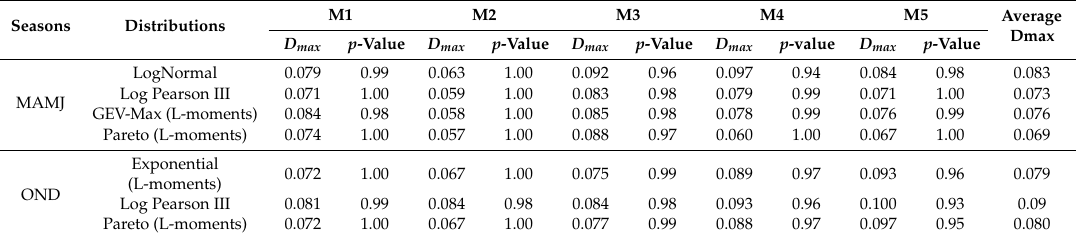
Table 8. Best-fitting distributions for the maximum one day rainfall in March–April–May–June (MAMJ) and October–November–December (OND) seasons for each station.